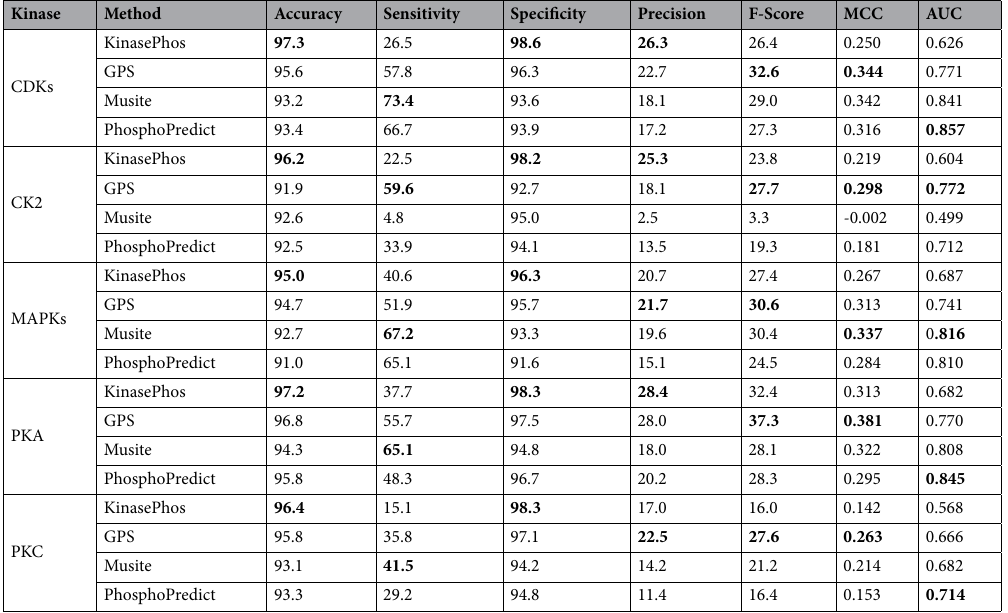
Table 6. Performance comparison of several prediction tools based on the UniProt_set. The best results for each kinase and performance measure are highlighted in